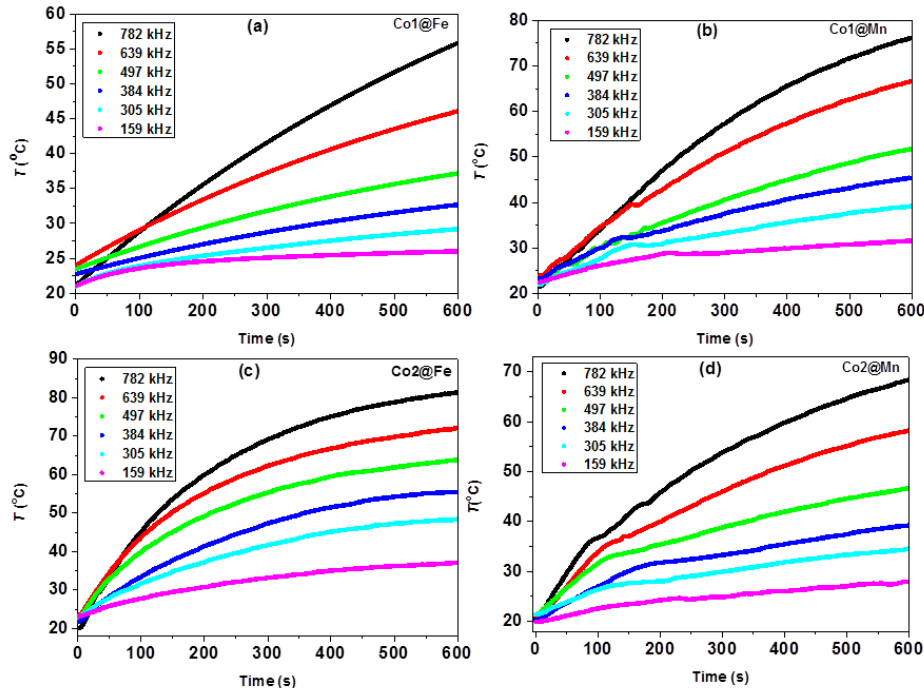
Figure 3. Temperature ramping of solution at different frequencies of AMF with field amplitude 31.6 mT ( a – d ). 31.6 mT ( a – d